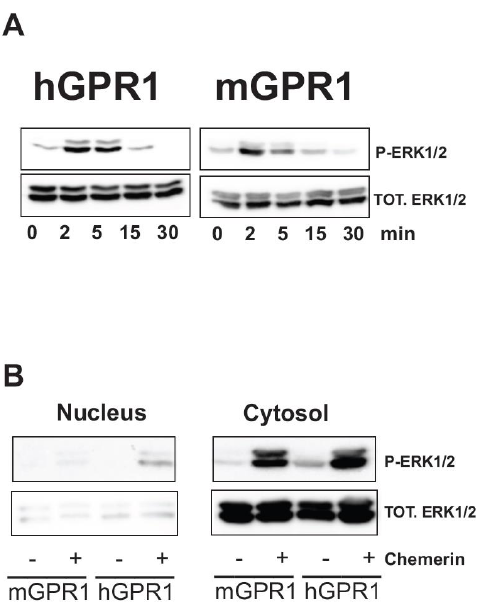
Figure 6. hGPR1 and mGPR1 activate MAP kinases ERK1/2. ( A , B ) Serum ‐ starved CHO ‐ K1 cells expressing hGPR1 or mGPR1 were stimulated with 50 nM chemerin for indicated times and the phospho ‐ ERK1/2 content was determined by immunoblotting. The phospho ‐ ERK1/2 content was analyzed in whole cell lysates ( A ) and in nuclear and cytosolic fractions ( B ). Detection of total ERK1/2 (lower panel) was used to ascertain that an equal amount of material was loaded in each lane. Quantitative data analysis was performed by using the ImageJ software. Data represent the mean ± SEM of three independent experiments.